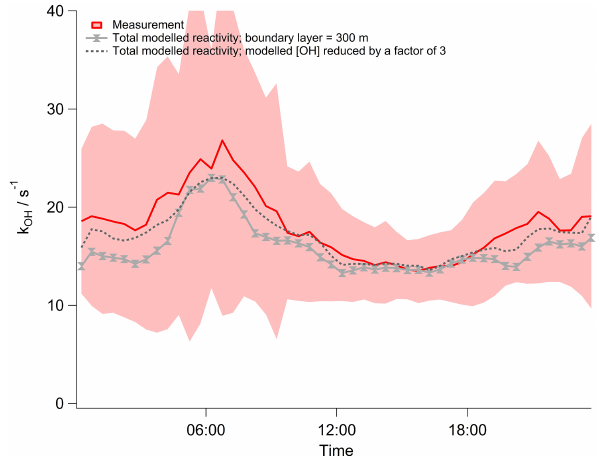
Figure 8. Average diurnal profile of the total modelled and mea- sured OH reactivity for different model scenarios (see text for fur- ther details); the level of agreement shown here can be compared to the model-measured agreement presented in Fig. 5. The shading represents the 1 σ variability of the measurements, with each data point representing 30min averaged